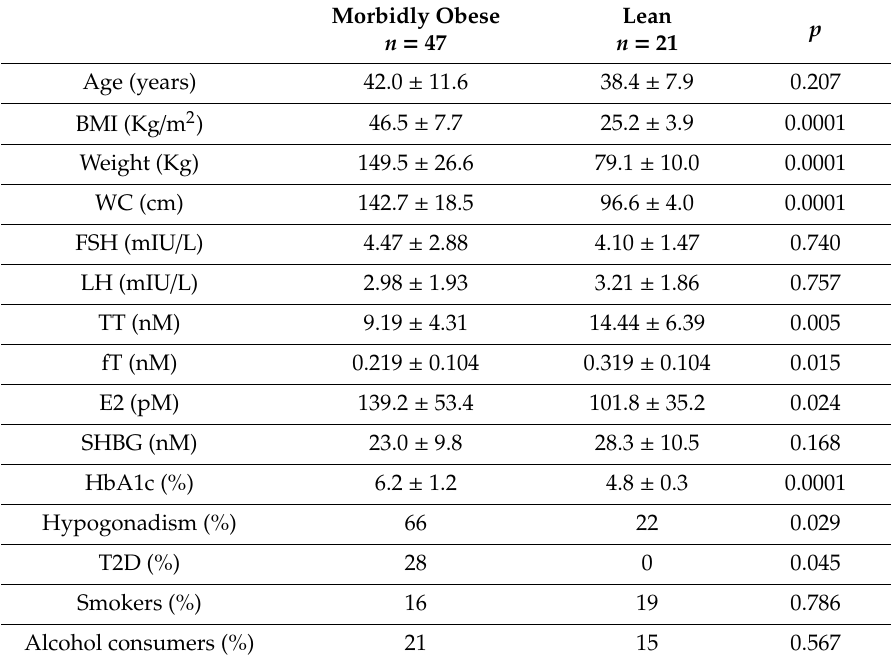
Table 1. Biochemical and anthropometric characteristics of the patients: Anthropometric data and circulating levels of sex steroid hormones, SHBG and HbA1c are reported along with the prevalence of hypogonadism (TT < 12 nM), T2D (HbA1c ≥ 6.5), smokers (at least 1 cigarette / day), and alcohol consumers (at least 2 drinks / day) in each cohort. Data was normally distributed and reported as mean ± SD. Two-tailed Student’s t-test p values for comparison between obese and lean subjects are shown; χ 2 was applied for comparison of non-continuous parameters (hypogonadism, T2D, smokers, alcohol consumers). Significant p values are indicated in italics. Morbidly Obese n =